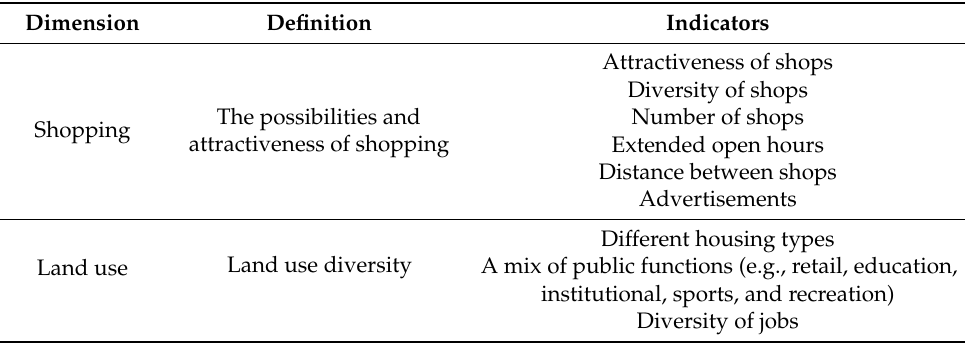
Table 2. Land use and shopping indicators measured in